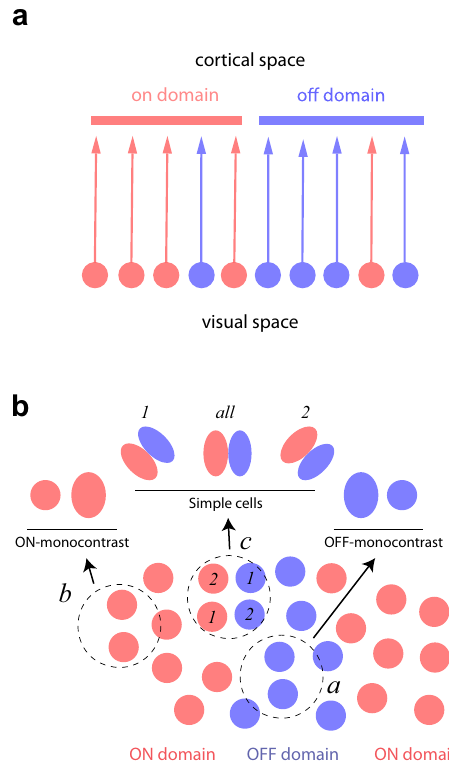
Fig. 3 A biased-input model of ON/OFF domains. a The cartoon depicts a 1D version of the biased-input model. The bottom layer shows the location and polarities of ON/OFF cells in the visual fi eld (ON = red, OFF = blue). The top layer shows the input of those signals into the cortex assuming an accurate retinotopy. Here, we readily see that fl uctuations in the relative density of ON and OFF cells ought to follow a corresponding fl uctuation in the density of ON and OFF receptive fi eld locations in the visual fi eld. Thus, ON/OFF domains could arise from a property of the input. Thalamic projections, of course, include axonal arborizations that are not depicted in this diagram to avoid clutter. b The cartoon represents a top view from the cortex of a set of geniculate ON and OFF-center inputs dominating the representation in different parts of the visual fi eld. We assume an accurate retinotopy, so the spatial distribution of ON/OFF receptive fi elds also represents the distribution of ON/OFF afferents into the cortex. We hypothesize that clusters of ON inputs establish cortical ON domains, and clusters of OFF inputs de fi ne OFF domains. Dashed circles represent neighborhoods over which three different cortical cells can sample the geniculate inputs. Such areas are determined by the extent of thalamic arborizations and the size of cortical dendritic trees. Cortical cells with access just to ( a ) OFF or ( b ) ON inputs will develop mono-contrast receptive fi elds with a single subregion of the corresponding